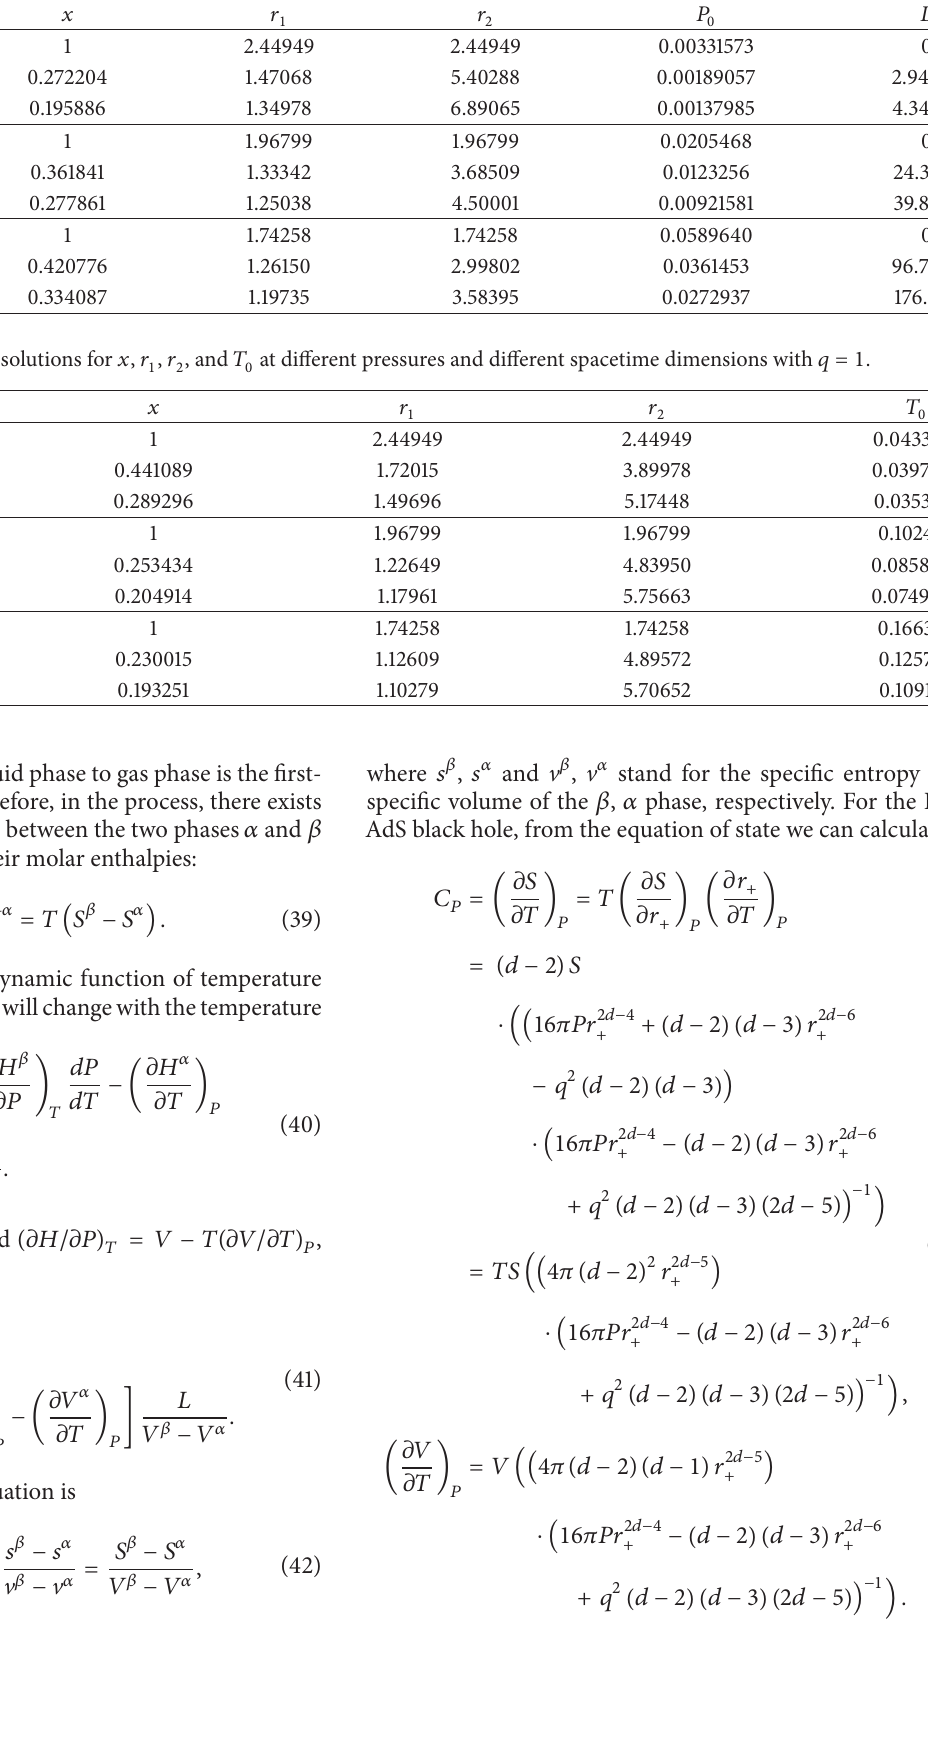
Table 1: Numerical solutions for 𝑥 , 𝑟 1 , 𝑟 2 , and 𝑃 0 and the latent heat 𝐿 at different temperatures and different spacetime dimensions with 𝑞 = 1 . 𝑑